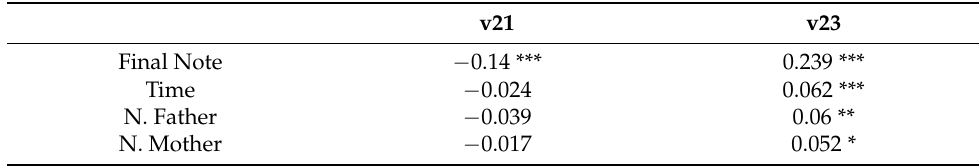
Table 9. Goodman and Kruskal gamma test. Perception of the instruments used to assess the degree of attainment of the competences. v21 v23 Final Note − 0.14 *** 0.239 *** Time − 0.024 0.062 *** N. Father − 0.039 0.06 ** N. Mother 0.052